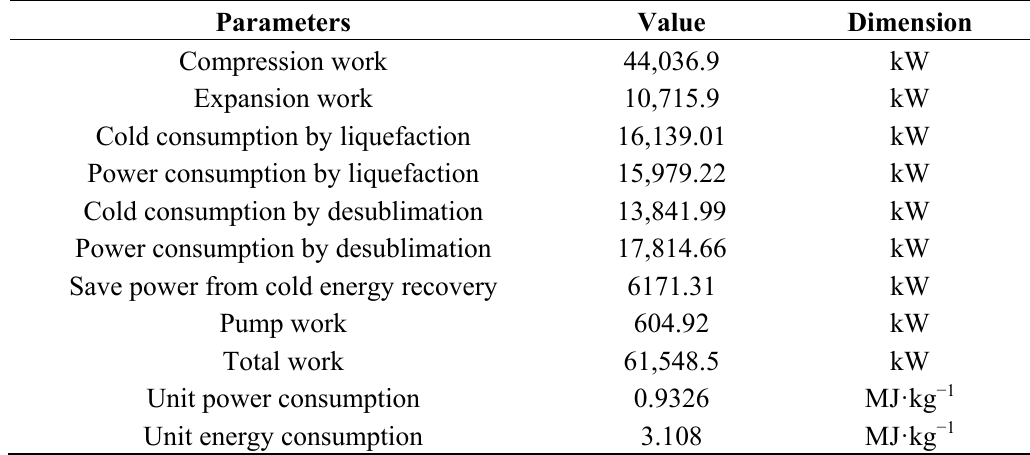
Table 5. Energy consumptions for CO 2 separation